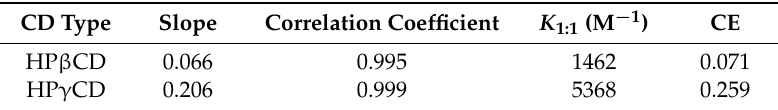
Table 3. Apparent stability constant K and the complexation efficiency (CE) of DXMa/cyclodextrin complexes at 25 ◦